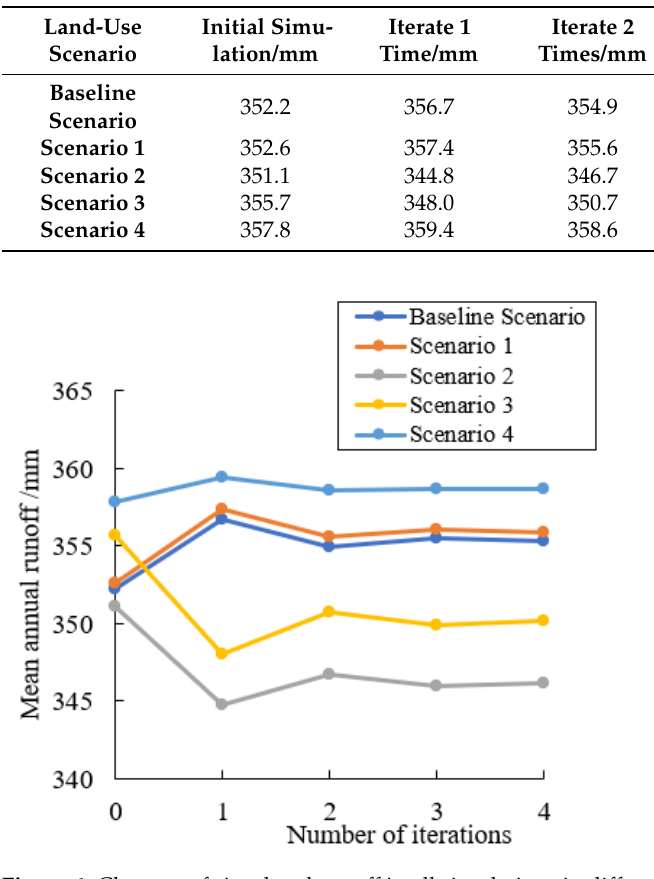
Figure 6. Changes of simulated runoff in all simulations in different scenarios.